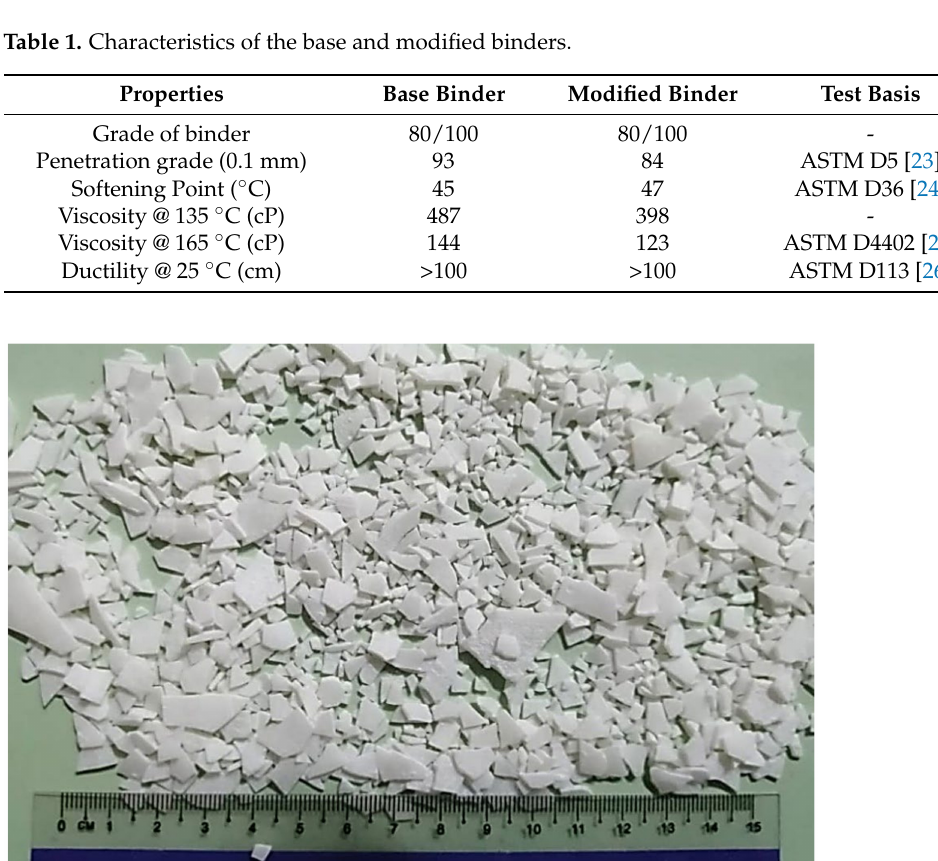
Figure 1. LEADCAP